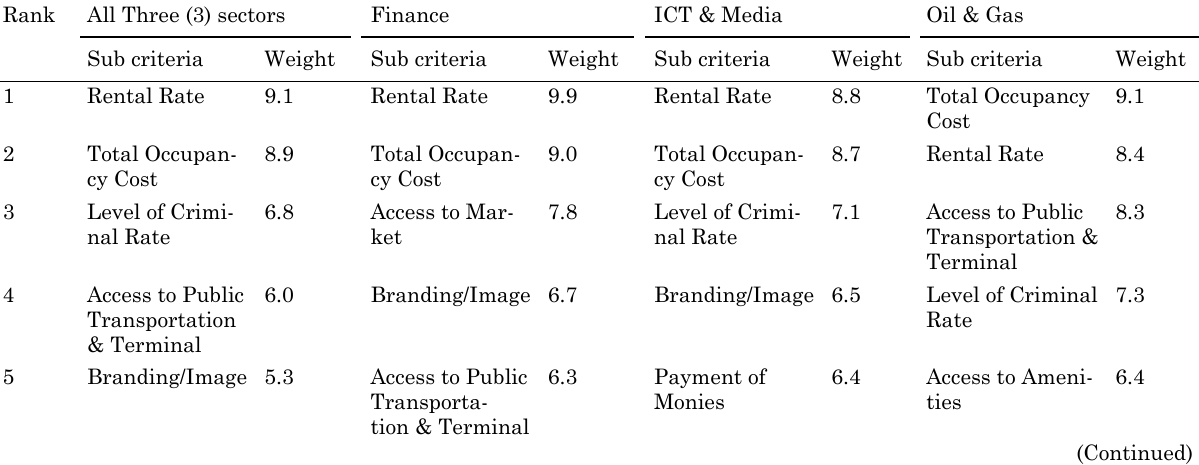
Table 3. Comparison of weights and ranks for each tenant sector of the sub criteria (global weight) in percentage (%) rank All Three (3)